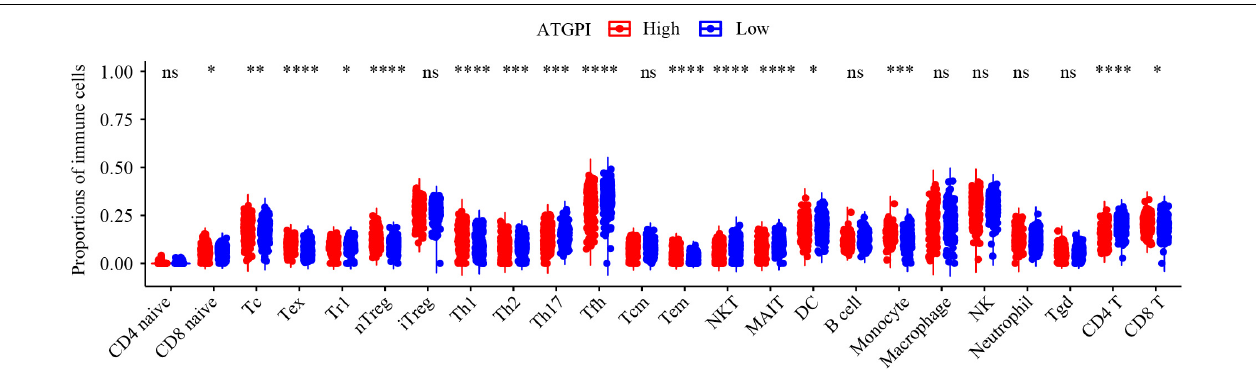
FIGURE 5 | The immune infiltration status of high- and low-autophagy-related gene pair index (ATGPI) groups in the TCGA validation cohort. The percentages of different tumor-infiltrating lymphocytes (TILs) were compared by Wilcoxon rank sum test. ns, P ≥ 0.05; * P < 0.05; ** P < 0.01; *** P < 0.001; **** P < 0.0001.